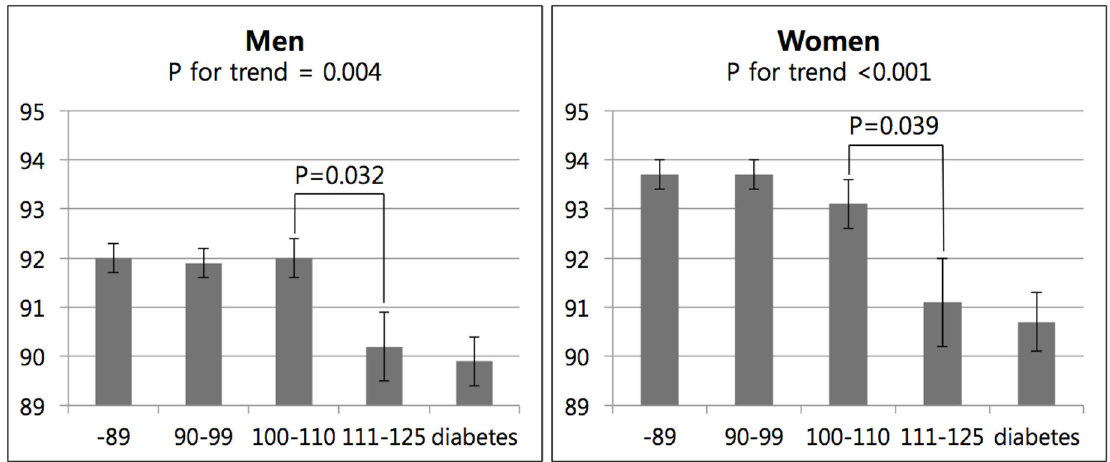
Figure 1. Predicted FVC% by fasting plasma glucose. Adjusted for age, smoking, exercise, and waist circumference. doi: